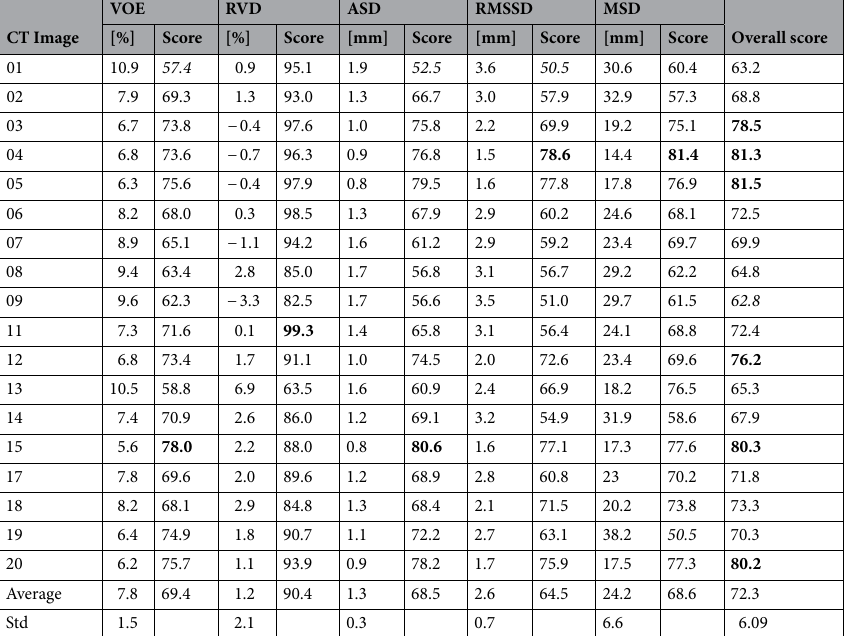
Table 4. The evaluation metrics obtained from 18 asymptomatic (labelled) cases. The bold means the best values in each column.